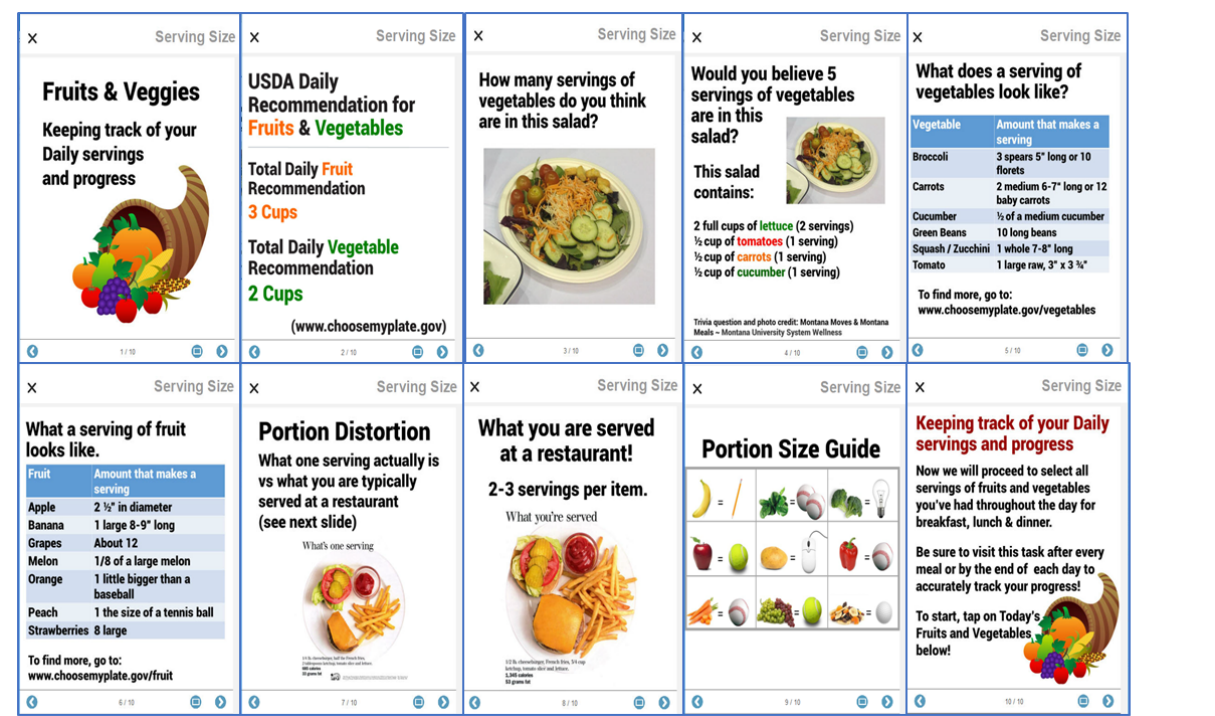
Figure 6. Explanation of fruit and vegetable serving size to support quality diary entries, along with educational materials supporting healthy eating choices and